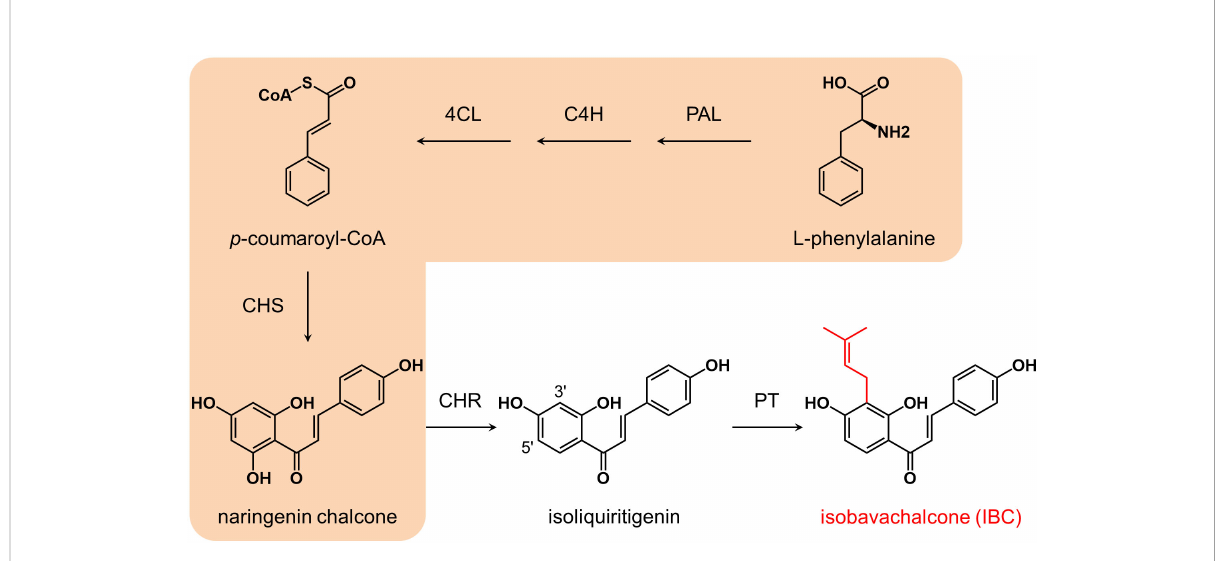
FIGURE 1 Biosynthesis pathway of isobavachalcone. Enzymes and compounds in the orange shadow commonly exist in higher plants, while CHR is mainly distributed in leguminous plants. Isobavachalcone is supposed to be synthesized via 3 ’ prenylation of isoliquiritigenin by a PT. PAL, phenylalanine ammonia-lyase; C4H, cinnamic acid 4-hydroxylase; 4CL, 4-coumarate: coenzyme A ligase; CHS, chalcone synthase; CHR, chalcone reductase; PT,